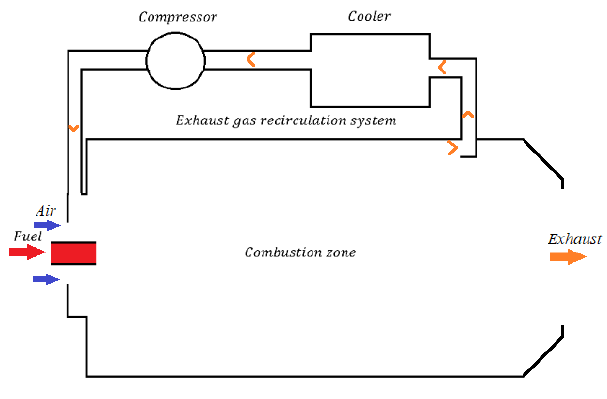
Fig. 8. Combustor with exhaust recirculation system (basing on